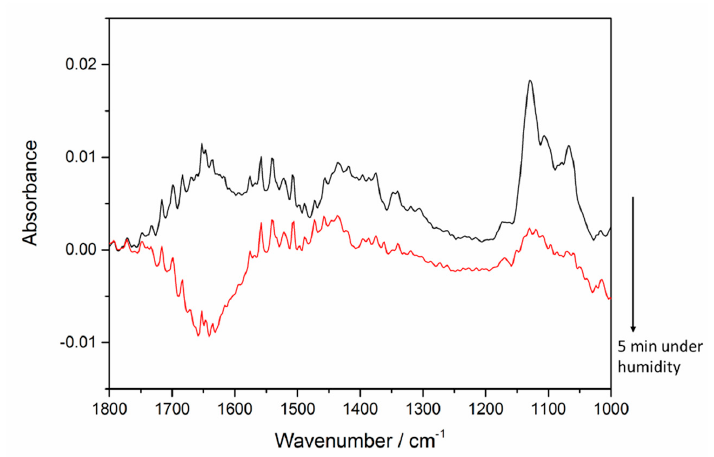
Figure 7. ATR-FTIR spectra recorded after purging an anatase film with acetaldehyde for 2 h, under dry conditions (black). In the presence of humidity, the band’s characteristics for acetaldehyde and crotonaldehyde decreased in intensity, within 5 min, indicating a desorption of both molecules (red). The following adsorption and degradation experiments of acetaldehyde, over TiO 2 , in the presence and absence of O 2 , were performed under dry conditions, because ATR-FTIR spectra of acetaldehyde and crotonaldehyde could be recorded, while under humidity, bands of acetaldehyde and crotonaldehyde did not